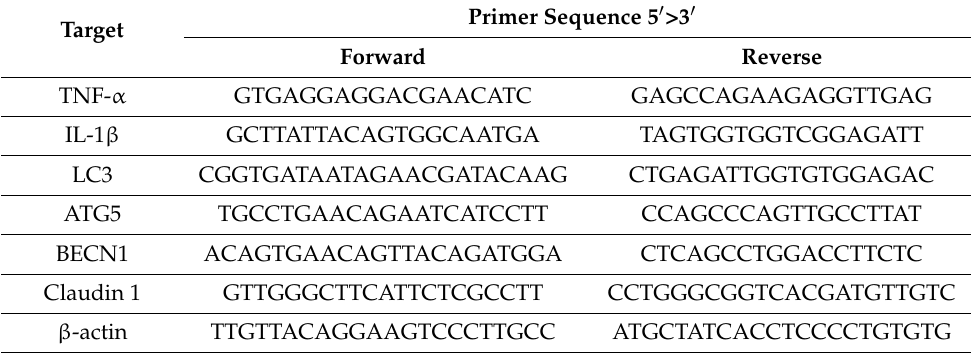
Table 1. Primers used for Real-time PCR analysis of gene expression.